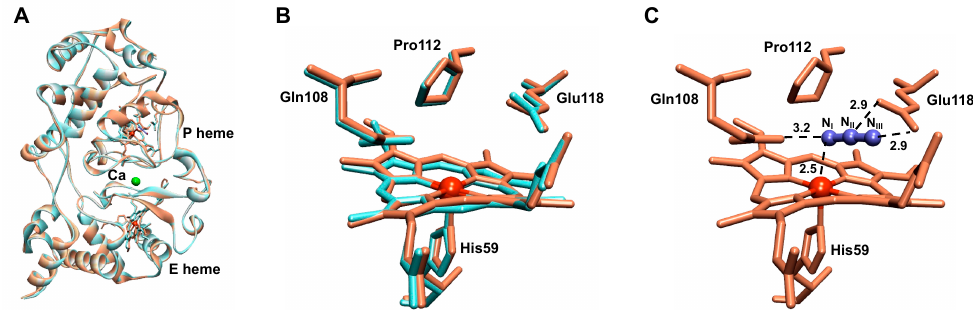
Figure 7. Structure comparison of the Ng BCCP active (blue) and azide-inhibited (orange) forms. Overall, the protein fold is conserved ( A ), as well as the residues in the active site ( B ). In the inhibited form there is an azide molecule, H-bonded to the conserved Gln108 and Glu118 ( C ). Figures prepared with BIOVIA Discovery Studio Visualizer 4.5.